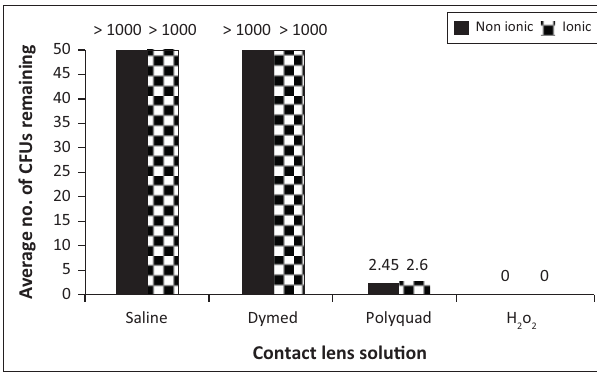
FIGURE 2: Solution effectiveness on non-ionic versus ionic soft contact lenses in removing Pseudomonas aeruginosa.